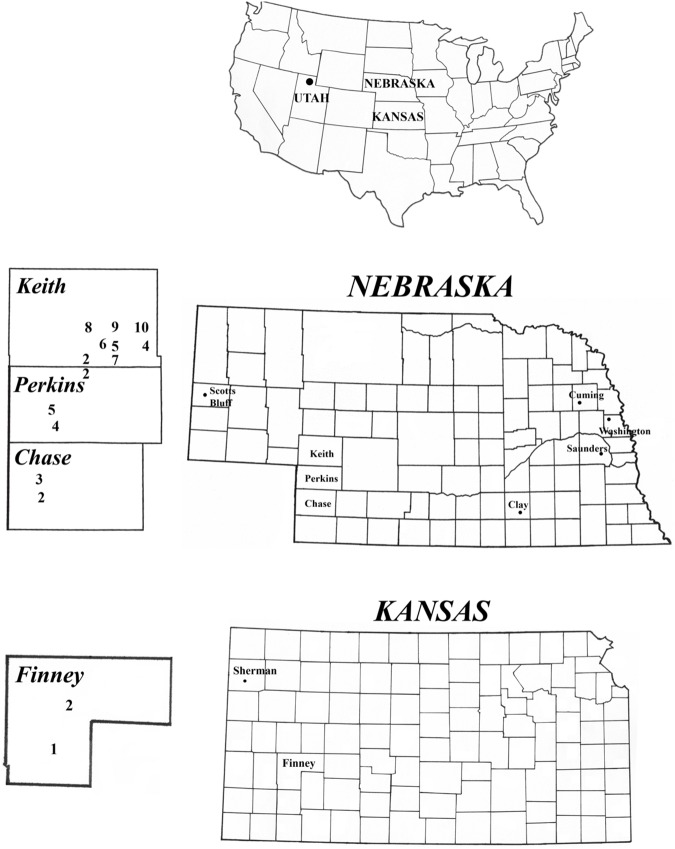
U.S. map showing states Utah, Nebraska (counties Keith, Perkins, Chase, Saunders, Clay, Cuming, and Washington), and Kansas (counties Sherman and Finney) where western corn rootworm beetles were collected for diagnostic concentration and susceptibility bioassays.Numbers in the enlarged counties Keith, Perkins, and Chase in Nebraska, and Finney in Kansas, correspond to population numbers listed from these counties in Fig 2 and Tables 2–4 and show spatially where collections were made. Dots within remaining counties and Utah also show spatial locations of collections.